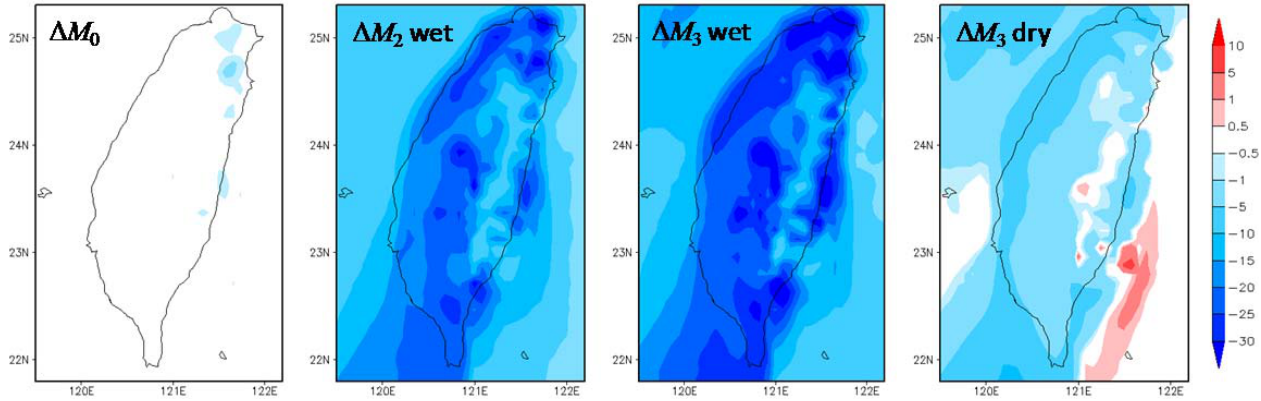
Figure 14: Left: simulated aerosol mass loading over the Taiwan area using SNAP for Brownian coagulation in the CMAQ model. Other panels from left to right: percentage difference between SNAP and GHQ in M , M and M , respectively. 0 2 3